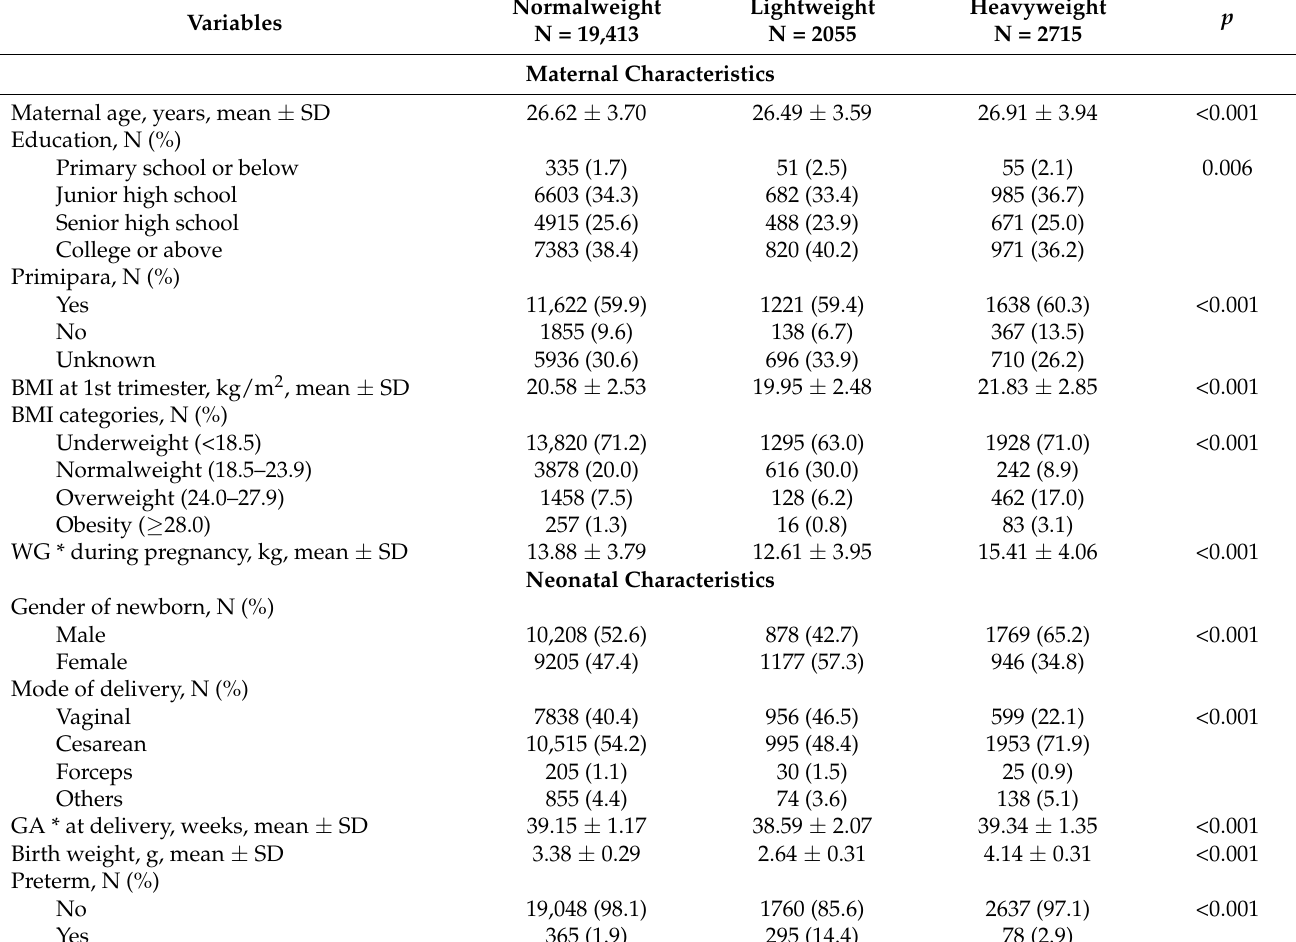
Table 1. Comparison of maternal and neonatal basic characteristics between